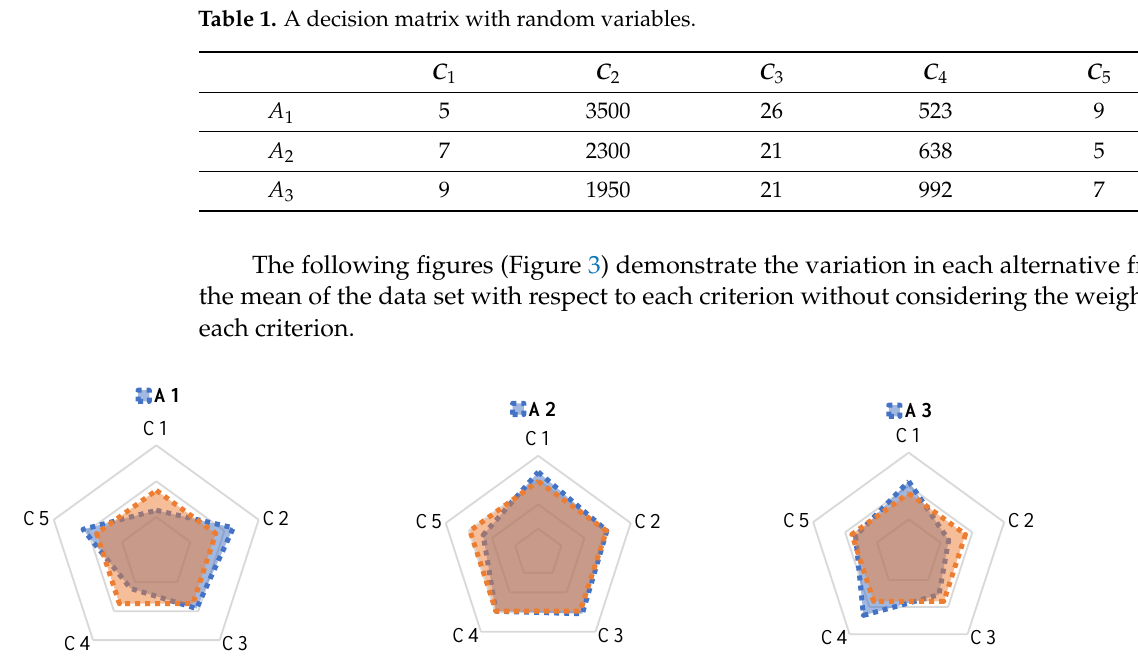
Figure 3. The variation in each alternative in the normalized decision matrix, where 𝐴 1 , 𝐴 2 , and 𝐴 3 are the alternatives.